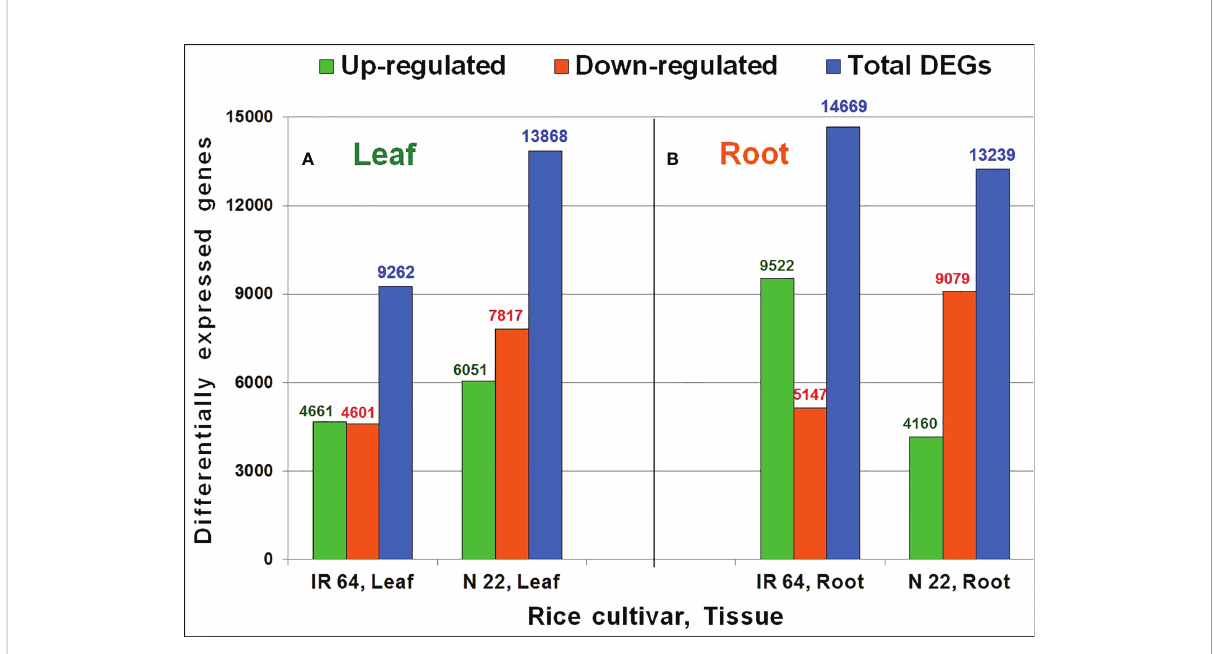
FIGURE 4 Differentially expressed genes (DEGs) in rice cultivars [IR 64 and Nagina 22 (N 22)] on direct-sowing over transplanting under drought stress imposed at reproductive stage in (A) leaf and (B) root. Leaf and root tissues were collected at the panicle-initiation stage of the plant for RNA- seq analysis.